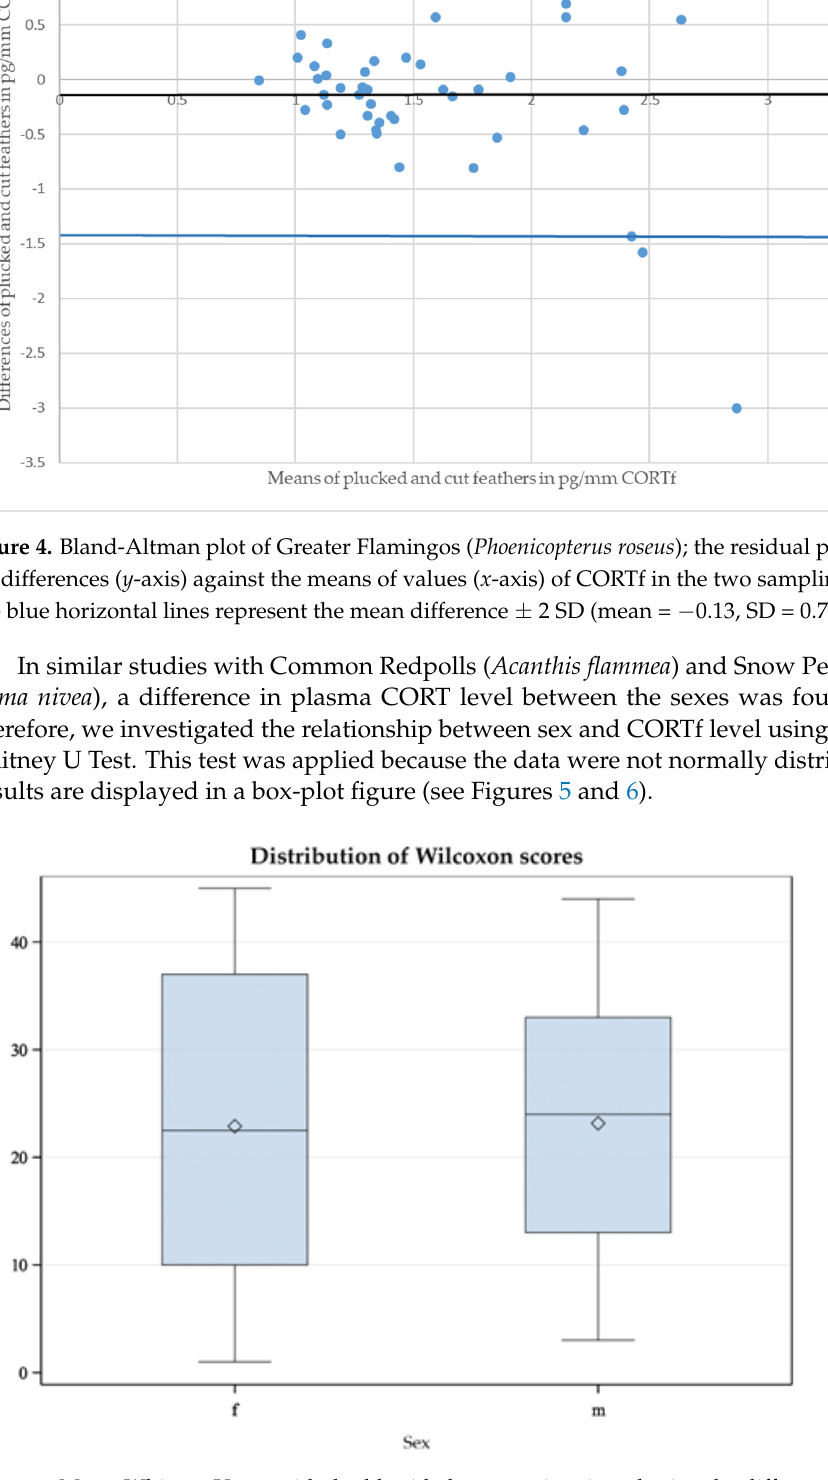
Figure 5. Mann-Whitney U test with double-sided t-approximation plotting the differences of female (f) and male (m) Mallards ( Anas platyrhynchos ) in their CORTf levels.